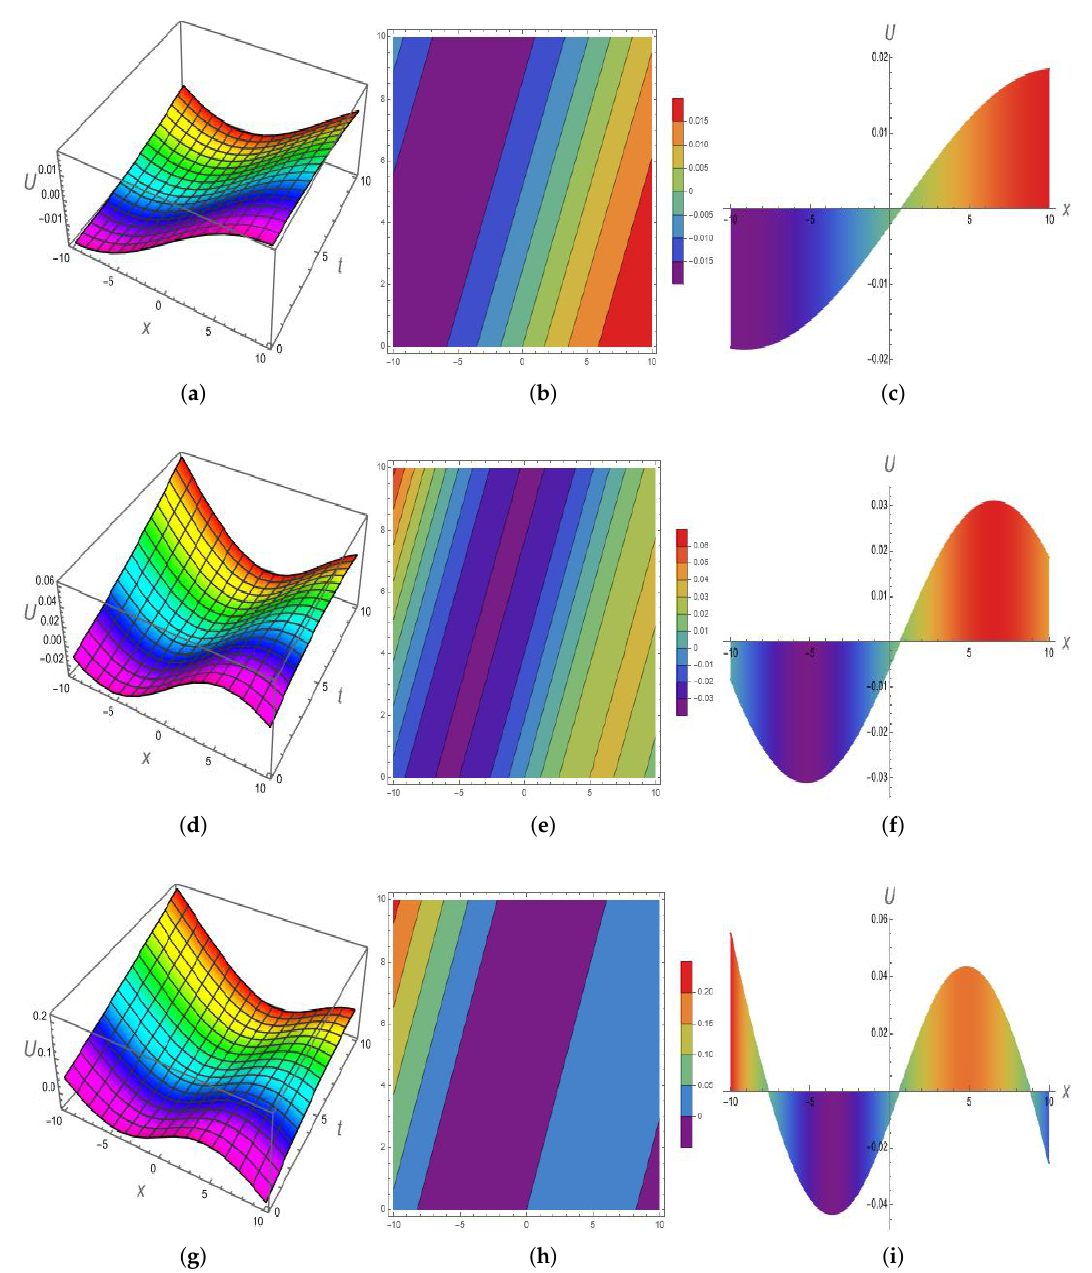
Figure 2. Three-dimensional, contour, and 2-D profiles of solution £ 4,3 for different values of pa- rameter k . ( a ) Three-dimensional propagation at k = 0.3; ( b ) Contour propagation at k = 0.3; ( c ) Two-dimensional propagation at k = 0.3; ( d ) Three-dimensional propagation at k = 0.5; ( e ) Con- tour propagation at k = 0.5; ( f ) Two-dimensional propagation at k = 0.5; ( g ) Three-dimensional propagation at k = 0.7; ( h ) Contour propagation at k = 0.7; ( i ) Two-dimensional propagation at k =